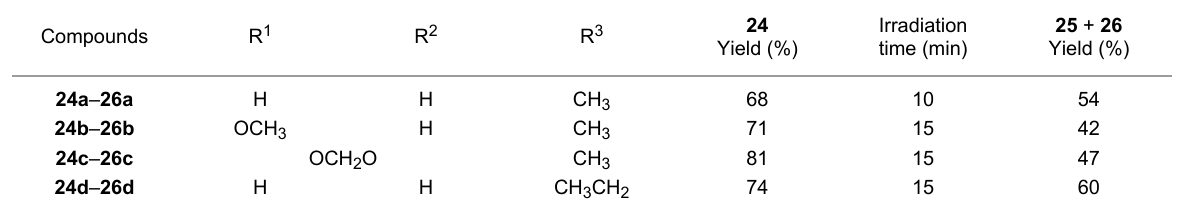
Table 2: Acetal-fulvenes 24 and benz[ f ]indenes 25 and 26